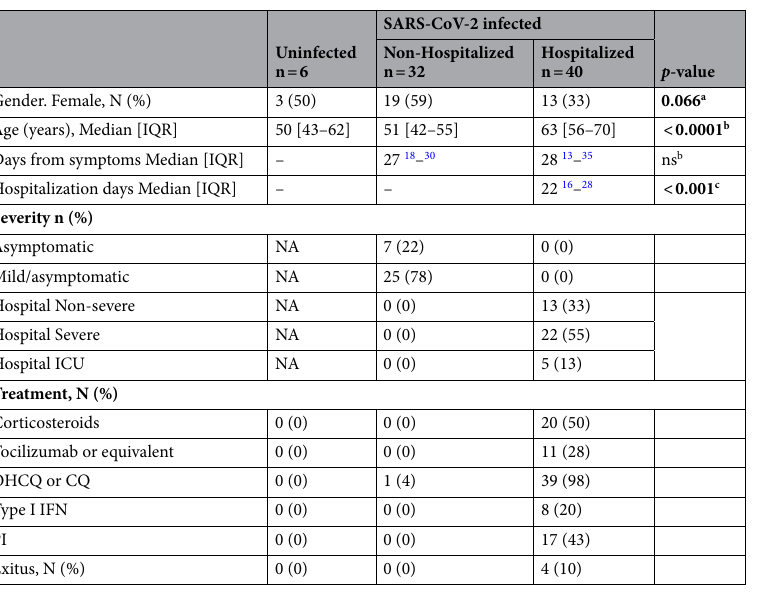
Table 1. Description of participants. Bold values indicate statistically significant differences. NA Not applicable. a Fisher exact test. b Kruskal–Wallis rank sum test. c Mann Whitney